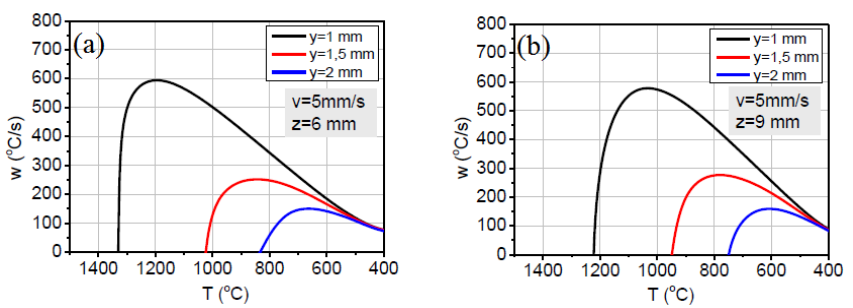
Figure 6. Cooling rates of structural steel-alloyed steel at electron-beam welding ( a ) at a depth of 6 mm; ( b ) at a depth of 9 mm.